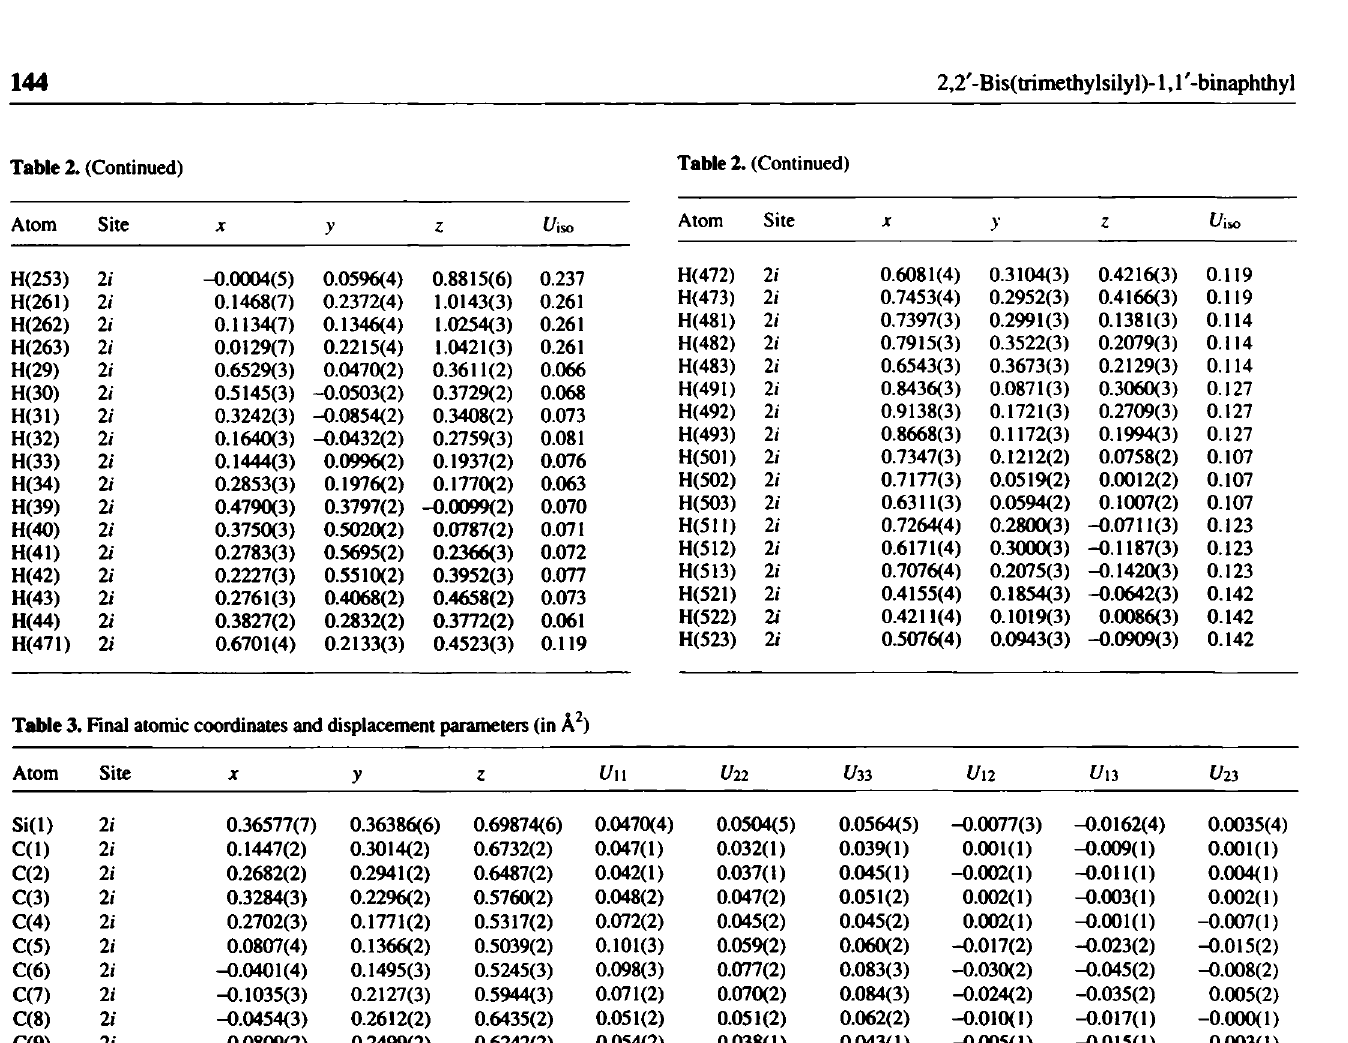
Table 3. Final atomic coordinates and displacement parameter (in Â 2